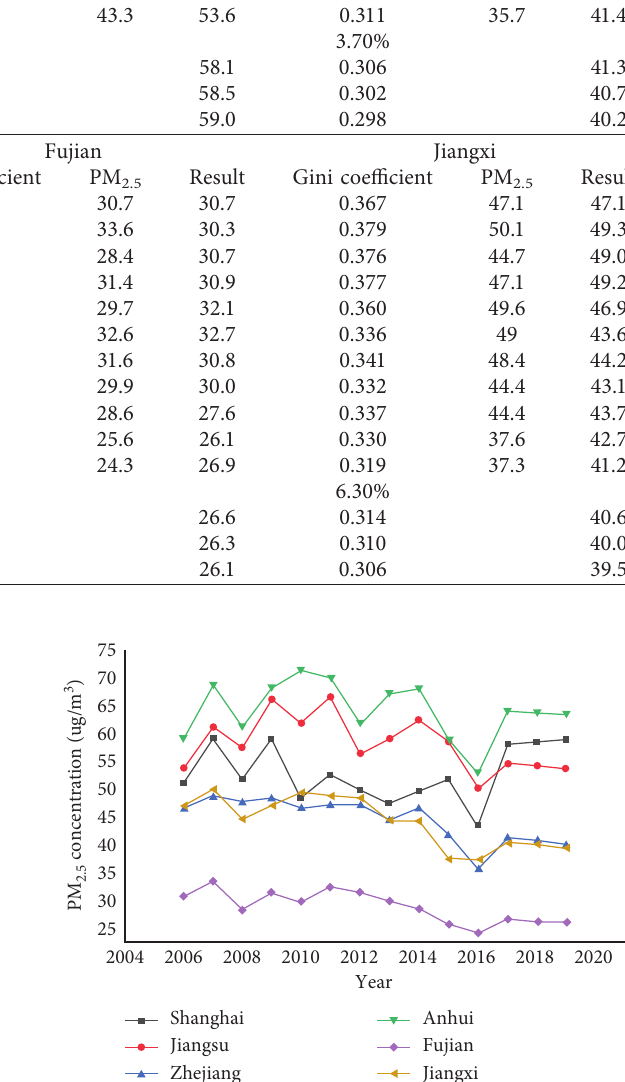
3: The PM 2.5 concentrations and prediction values of East